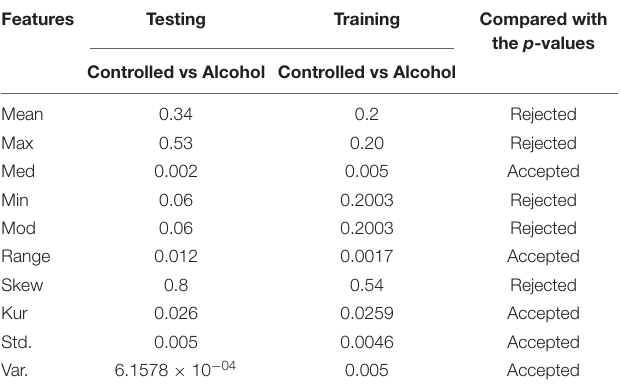
TABLE 4 | Feature set outcome of Experiment No. 4.